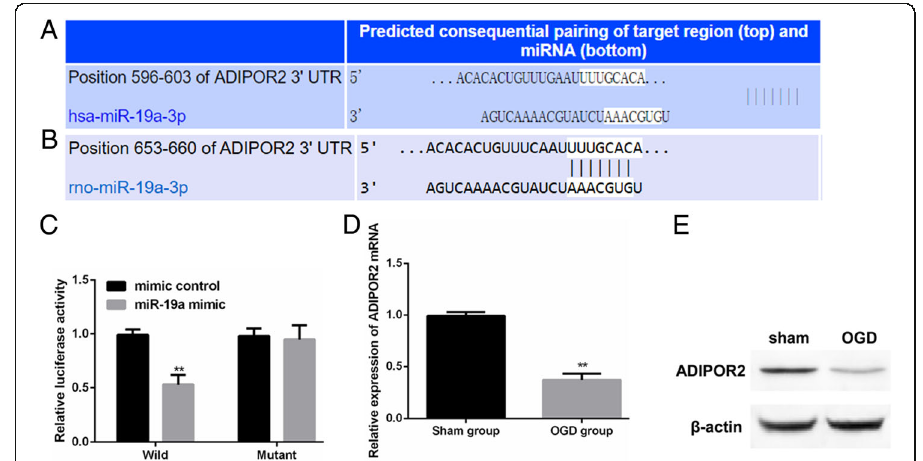
Fig. 5 Adipor2 is a bona fide target of miR-19a-3p. a , b Predicted (using TargetScan) target site of miR-19a- 3p in the 3 ′ -UTRs of human ( a ) and rat ( b ) ADIPO2 mRNA. c , Relative activities of wild-type and mutant (miR-190-3p binding site deletion mutant) luciferase reporters in neurons transfected with miRNA-19a-3p mimic or control. Data represent mean ± standard deviation of three independent experiments. d , e , Adipor2 mRNA ( d ) and protein ( e ) expression in OGD and control groups. All data are representative of three independent experiments and were expressed as means ± SD. (** P < 0.01 vs. control